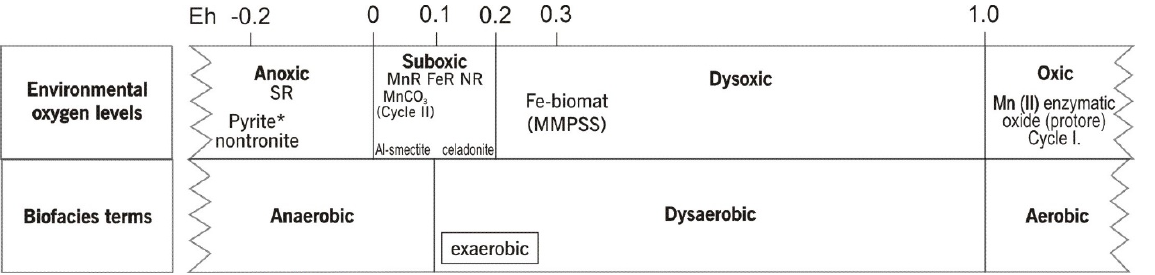
Table 2. Environmental oxygen levels.